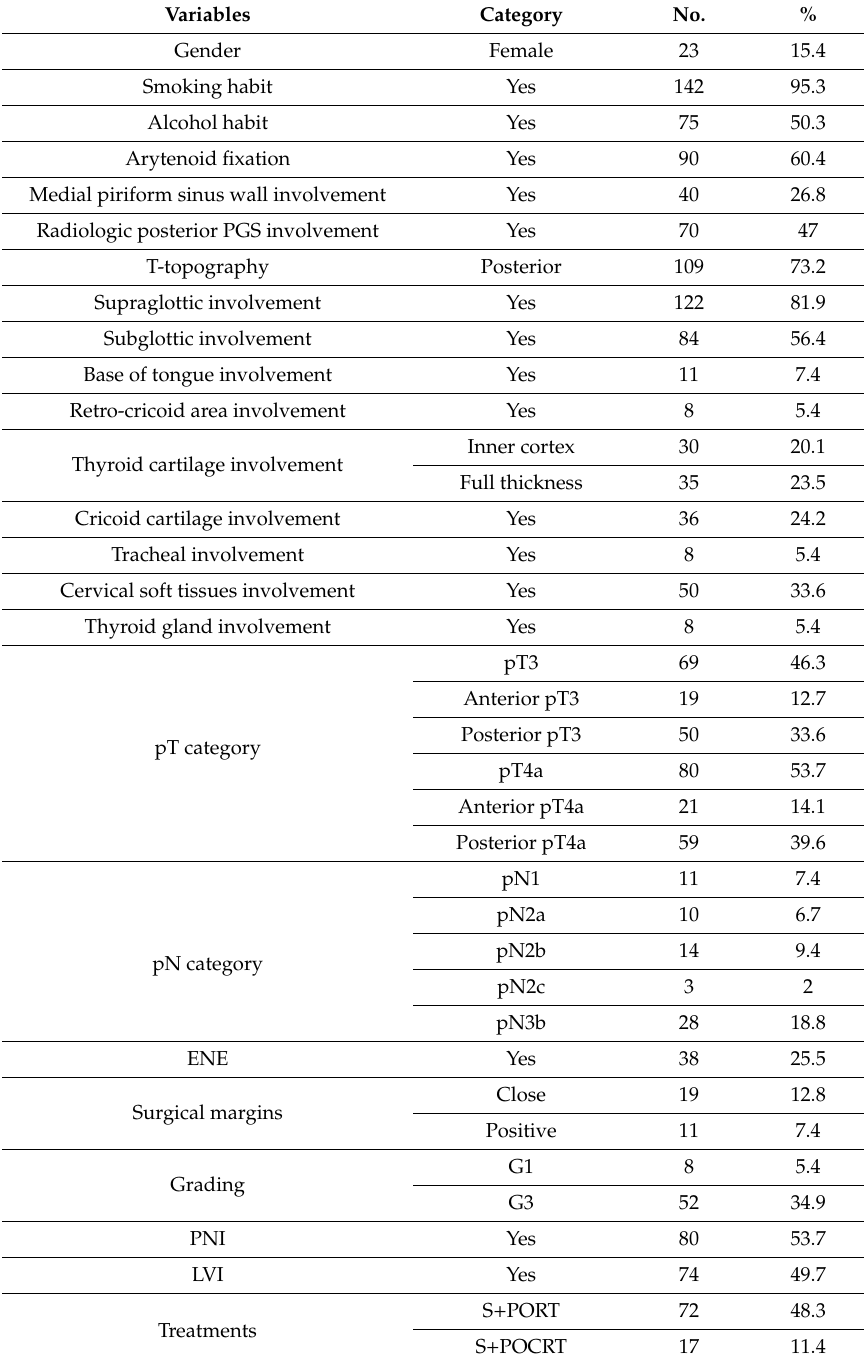
Table 1. Clinical and pathologic characteristics of the